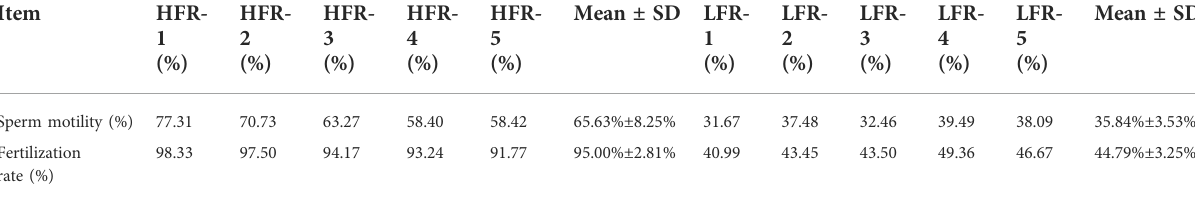
TABLE 1 Sperm motility and fertilization rate of Yili geese with high and low sperm motility.